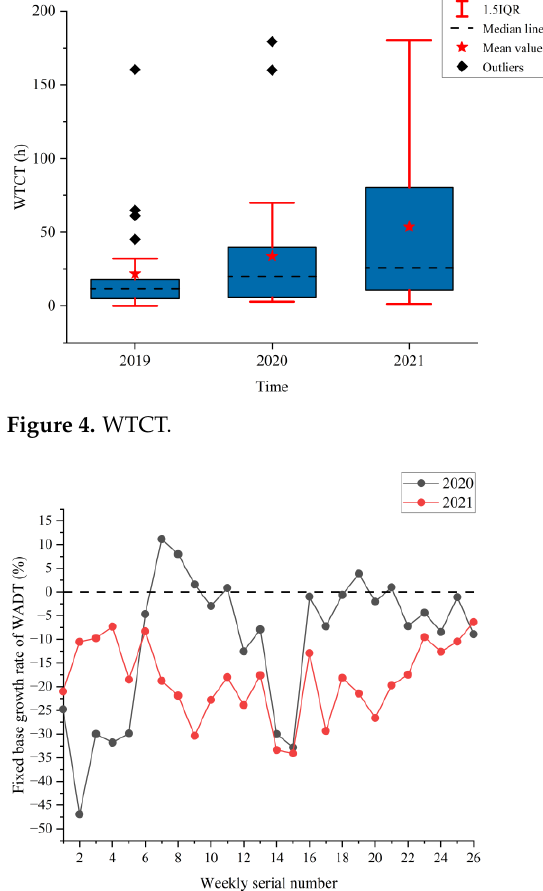
Figure 5. Fixed base growth rate of WADT.